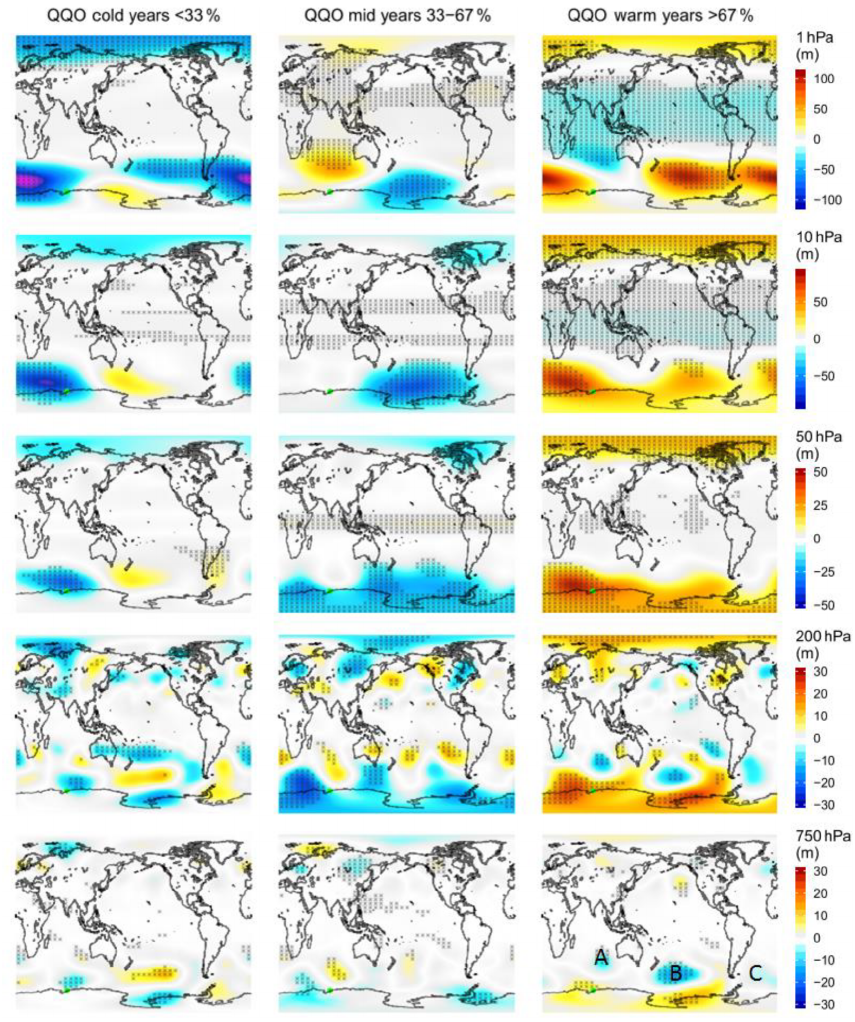
Figure 3. Composites of the ERA5 (AMJJAS) geopotential anomaly, for cold, mid, and warm years of the Davis detrended winter average QQO signal. Pressure levels are indicated on the right-hand colour bar. The colour scales are in metres of geopotential height. Hashed areas on the plots are significant at the 90%